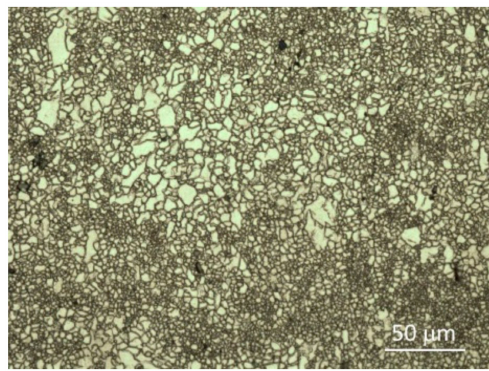
Figure 2. Microstructure taken from the ARB_1 surface.